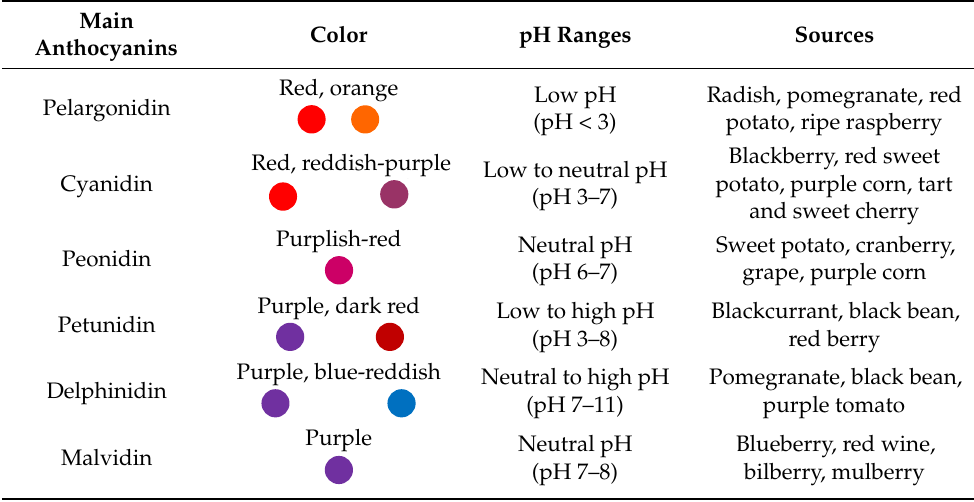
Table 1. Colors and sources of the six most well-studied anthocyanins [21,39,40].